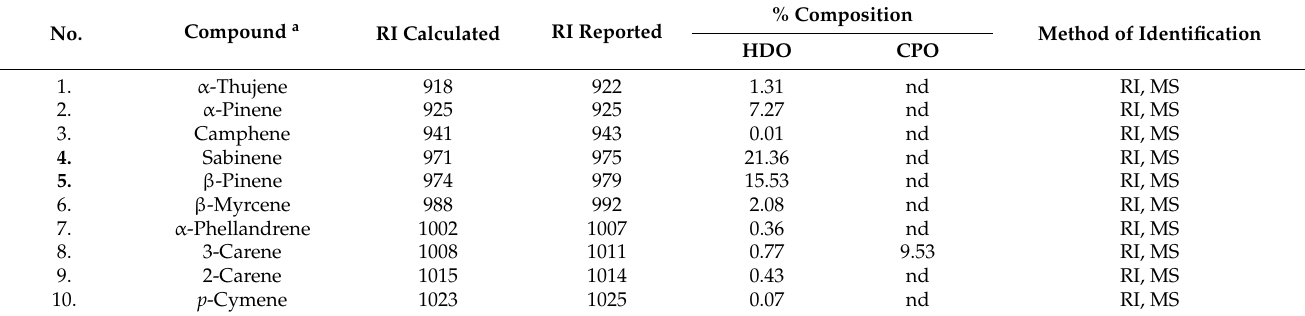
Table 1. Chemical composition of black pepper hydrodistilled (HDO) and cold-pressed (CPO) oils.